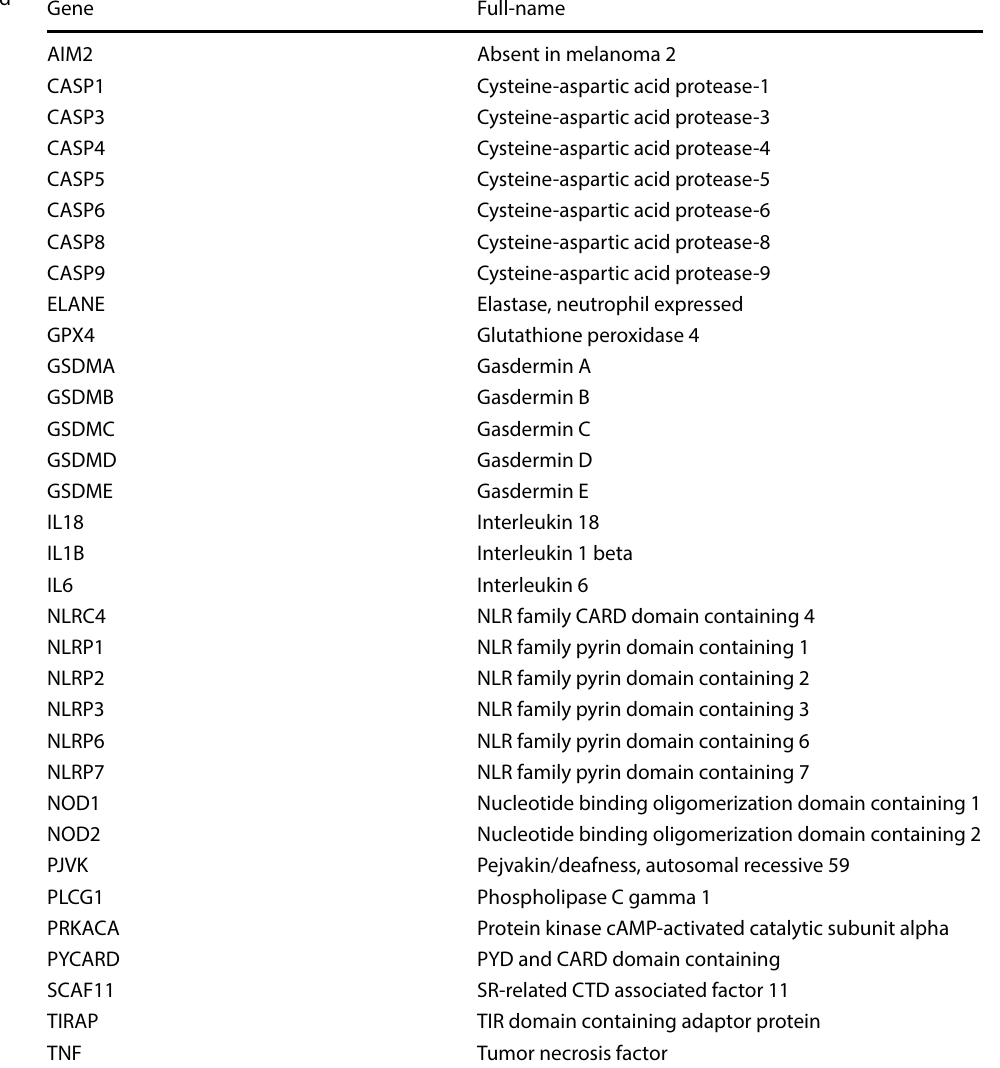
Table 2 33 pyroptosis-related